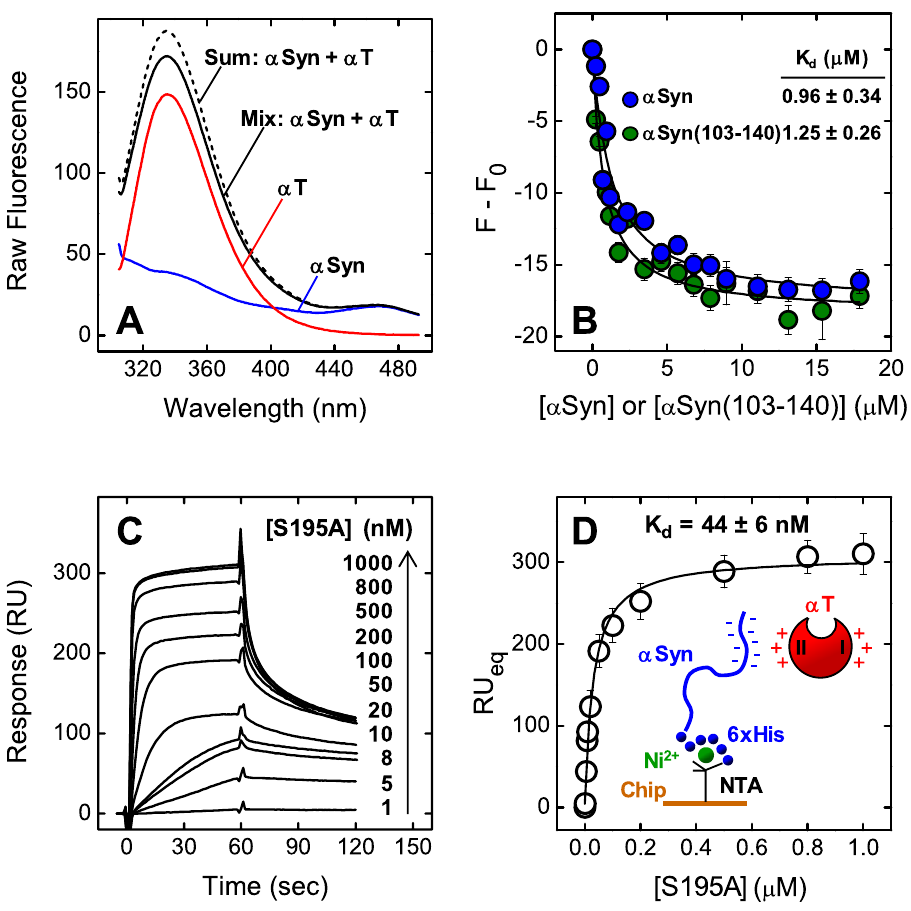
Figure 7. Probing αT-αSyn interaction by fluorescence spectroscopy and surface plasmon resonance. ( A ) Fluorescence spectra of isolated αSyn (20 μM) and αT (70 nM), and of the experimental complex containing the interacting proteins at the corresponding concentrations , as indicated. For comparison, the theoretical sum spectrum (--) is also reported. Emission spectra were recorded in HBS at 37 °C, after excitation at 295 nm, and subtracted for the corresponding baseline. ( B ) Fluorescence binding measurements of αSyn interaction with αT. To a solution of αT (70 nM) in HBS at 37 °C were added aliquots (2–20 μl) of full-length αSyn ( ) and αSyn(103–140) ( ). The samples were excited at 295 nm, and the emission intensity was recorded at 334 nm. Each spectrum was subtracted for the contribution of αSyn alone at the corresponding concentration and expressed as F − F 0 , where F and F 0 are the fluorescence intensity in the presence or absence of αSyn derivatives. The data points were interpolated with Eq. 5 (Supplementary Material), yielding the K d value as indicated. ( C , D ) SPR analysis of αT binding to immobilized αSyn. Recombinant wild-type 6xHis-αSyn was immobilized onto a Ni 2+ -NTA sensor chip and increasing concentrations of S195A thrombin mutant were injected in the mobile phase. ( C ) Representative sensograms relative to the binding of S195A. ( D ) Plot of RU max vs. S195A concentration ( ○ ). Fitting of data points with Eq. 8 (Supplementary Material) yielded the K d value for the synuclein-thrombin complex, as indicated. All SPR measurements were carried out at 37 °C in HBS-EP + . The data points are the average of three independent measurements (n = 3), with errors as ±